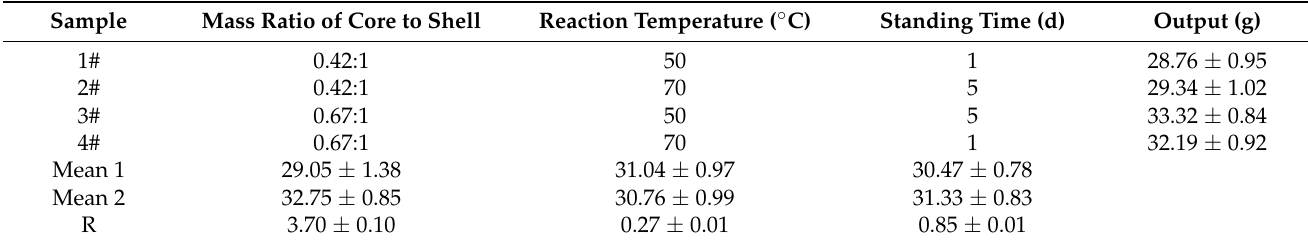
Table 4. Range results of microcapsule output by the orthogonal test.